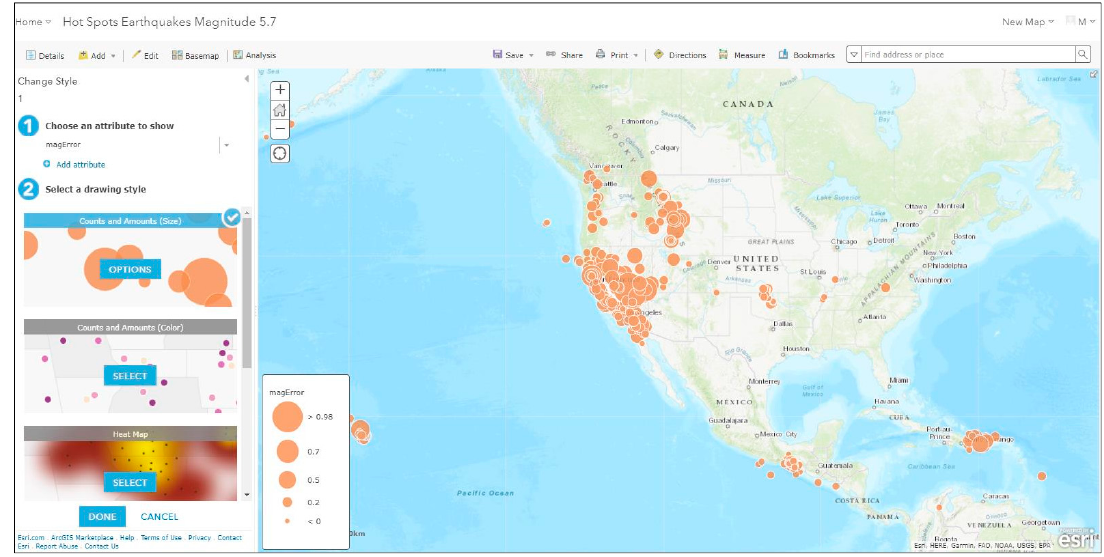
Figure 1. Mapping earthquake distributions with smart mapping tools.